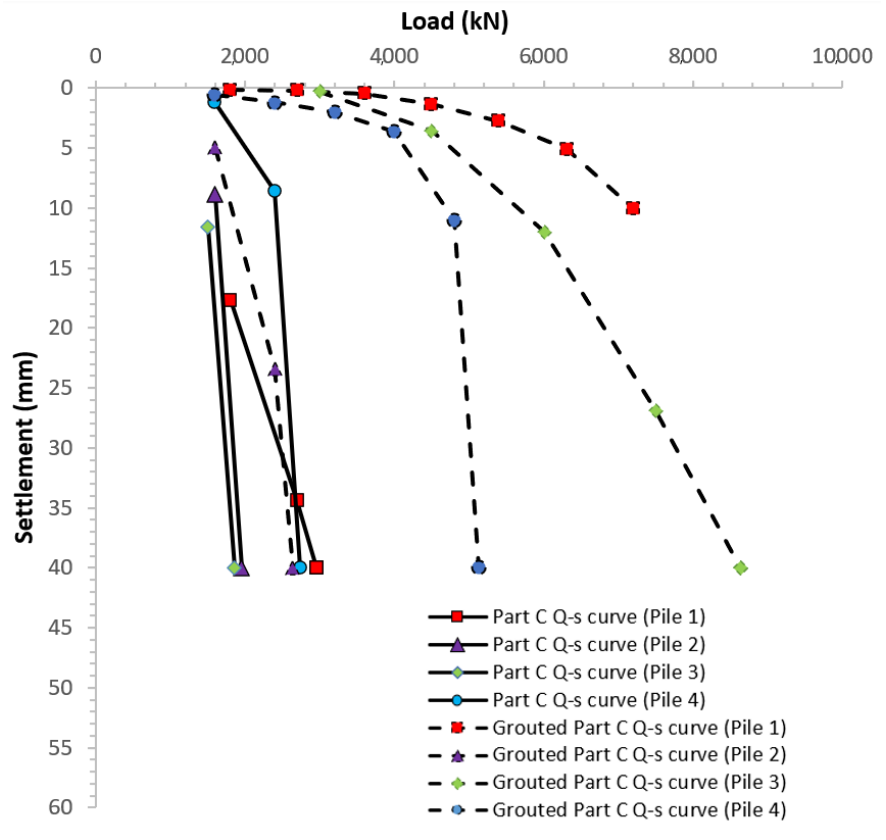
Figure 10. Interpreted load–settlement response of lower part (Part C). Table 6. Interpreted e nd bearing capacities of test piles.